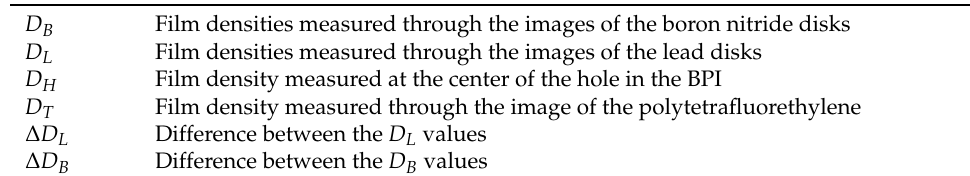
Table 1. Definitions of D parameters [20]. D B